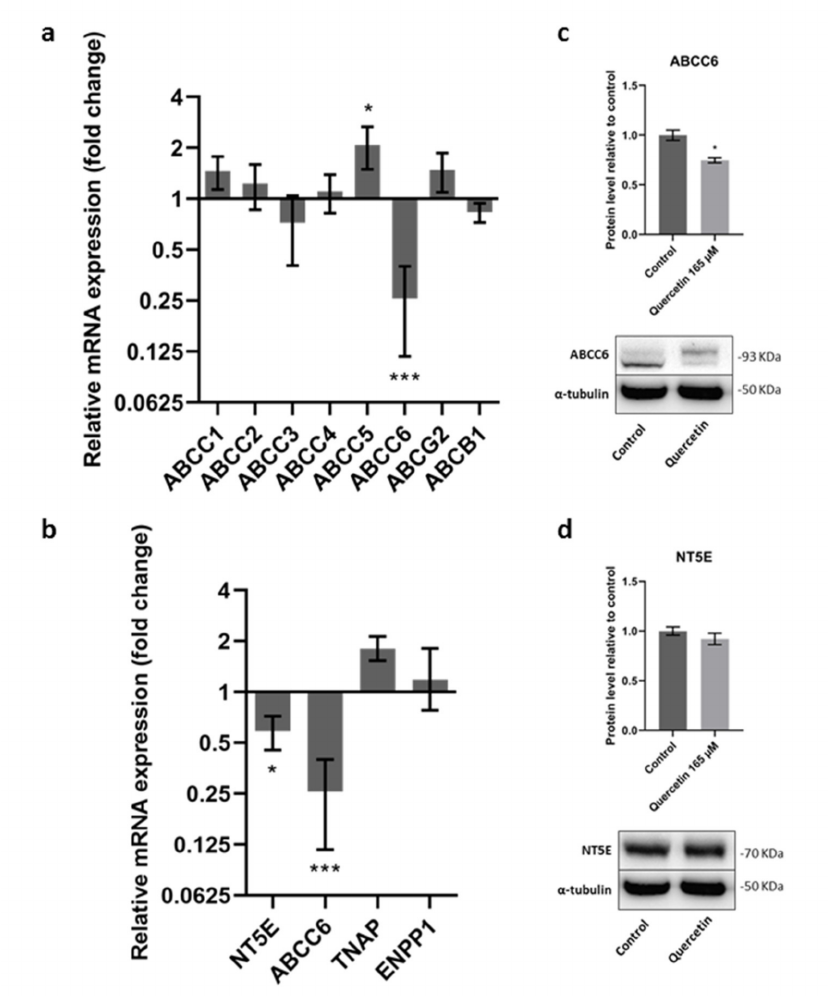
Figure 3. Effect of Quercetin on mRNA expression of some relevant ABC transporters ( a ) and on genes involved in the purinergic pathway ( b ). HepG2 cells were treated with Quercetin (165 µ M) for 24 h. Cells treated with 0.25% DMSO were used as a control. Results are expressed as the mean and 95% confidence interval of three different experiments. Statistical analysis was performed on ∆ Ct values by using multiple T-test followed by Holm–Sidak correction for multiple comparisons; * p < 0.05; *** p < 0.001. Effect of Quercetin on ABCC6 ( c ) and NT5E ( d ) protein expression. Results are expressed as the mean ± the standard error of three independent experiments. Results were analyzed by Student’s t test; * p <